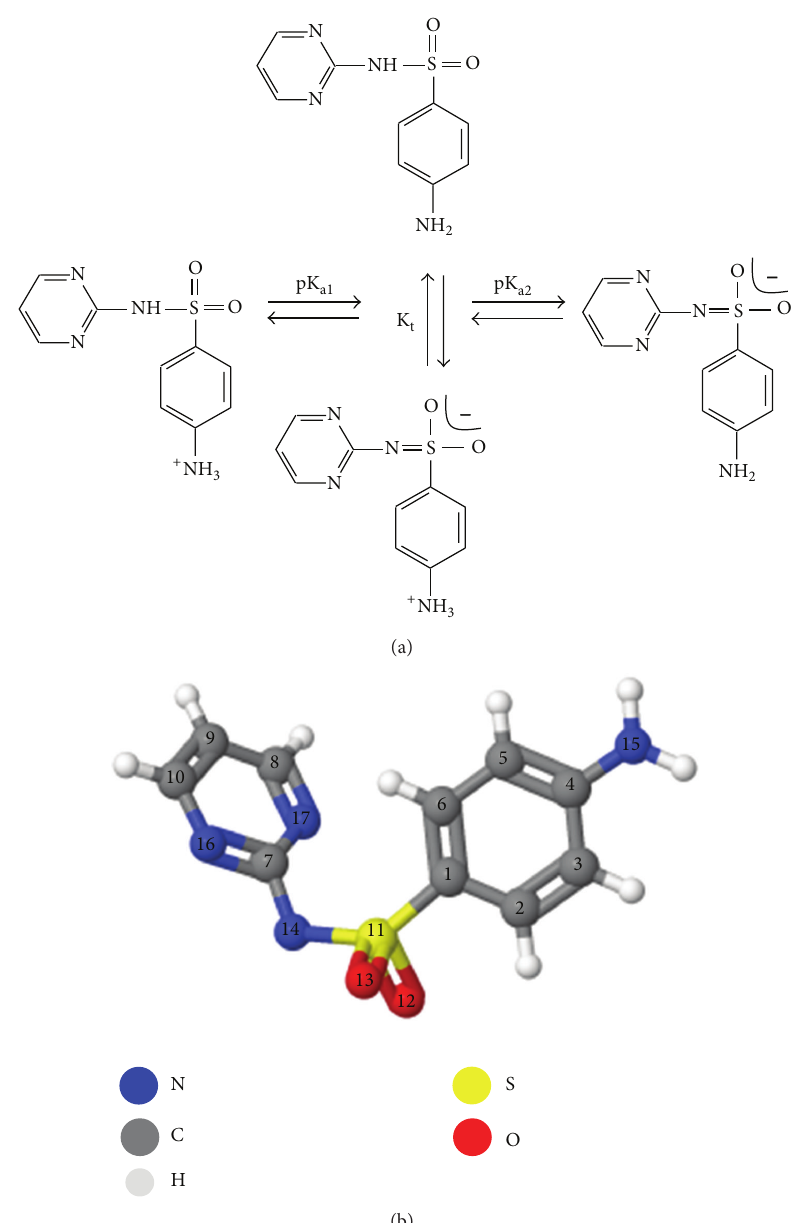
Figure 1: Speciation of SDZ (a) and its 3d arrangement of C, N, and S